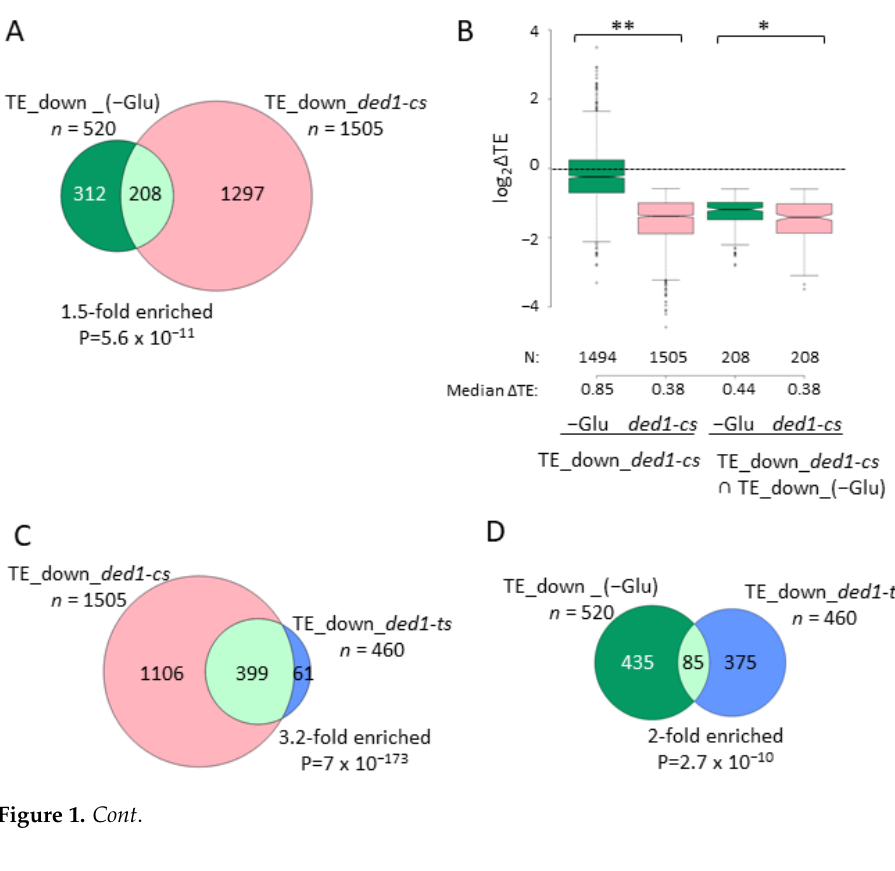
Figure 1. A significant fraction of Ded1-hyperdependent mRNAs in glucose-replete conditions is translationally down-regulated by glucose starvation. ( A ) Venn diagram of overlap between 520 mRNAs exhibiting ≥ 1.5-fold decrease in TE at FDR < 0.05 in WT cells under − Glu versus +Glu con- ditions (TE_down_( − Glu) group) and 1505 mRNAs showing a comparable decrease in TE in ded1-cs versus WT cells shifted to low temperature in a glucose-replete medium (TE_down_ ded1-cs group) out of a total of 5474 mRNAs for which ribosome-profiling data were obtained in the ded1-cs exper- iment. TE change values were calculated from published ribosome-profiling data deposited on GEO: − Glu/+Glu, GSE51532; ded1-cs /WT, GSE 111255. For this and all Venn diagrams below, the fold-enrichment and p value for the overlap was assigned using a hypergeometric distribution. ( B ) Notched box plot analysis of the log2 fold-changes in TE (log2 ∆ TE) observed in response to glucose starvation ( − Glu), the ded1-cs mutation for the 1505 TE_down_ ded1-cs mRNAs (col. 1–2), or the 208 mRNAs in the overlap between the TE_down_( − Glu) and TE_down_ ded1-cs mRNAs in panel A (cols. 3–4). In this and all box plots below, each box depicts the interquartile range containing 50%